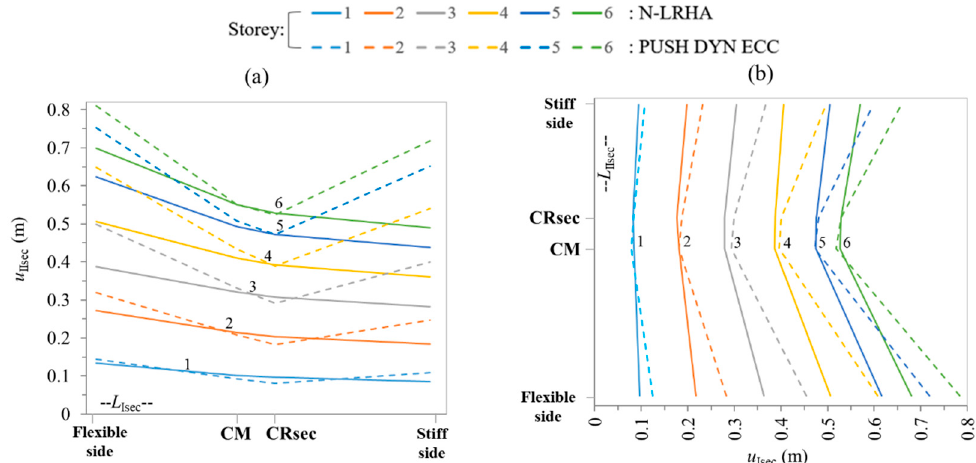
Figure 11. Plan inelastic displacement profiles of case 1 building at NC: ( a ) u IIsec along the II sec axis, ( b ) u Isec along the I sec axis. Proposed pushover procedure vs. N-LRHA.